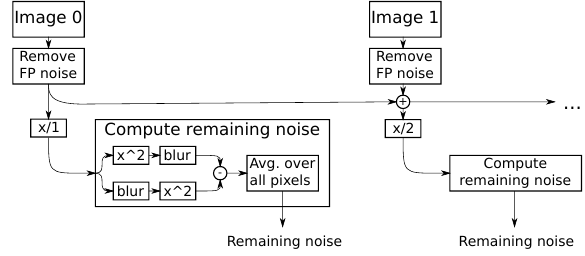
Figure 4. Contrast enhanced visualization of the FPN model. Off- set o (left) and scale s (right) for all three color channels.